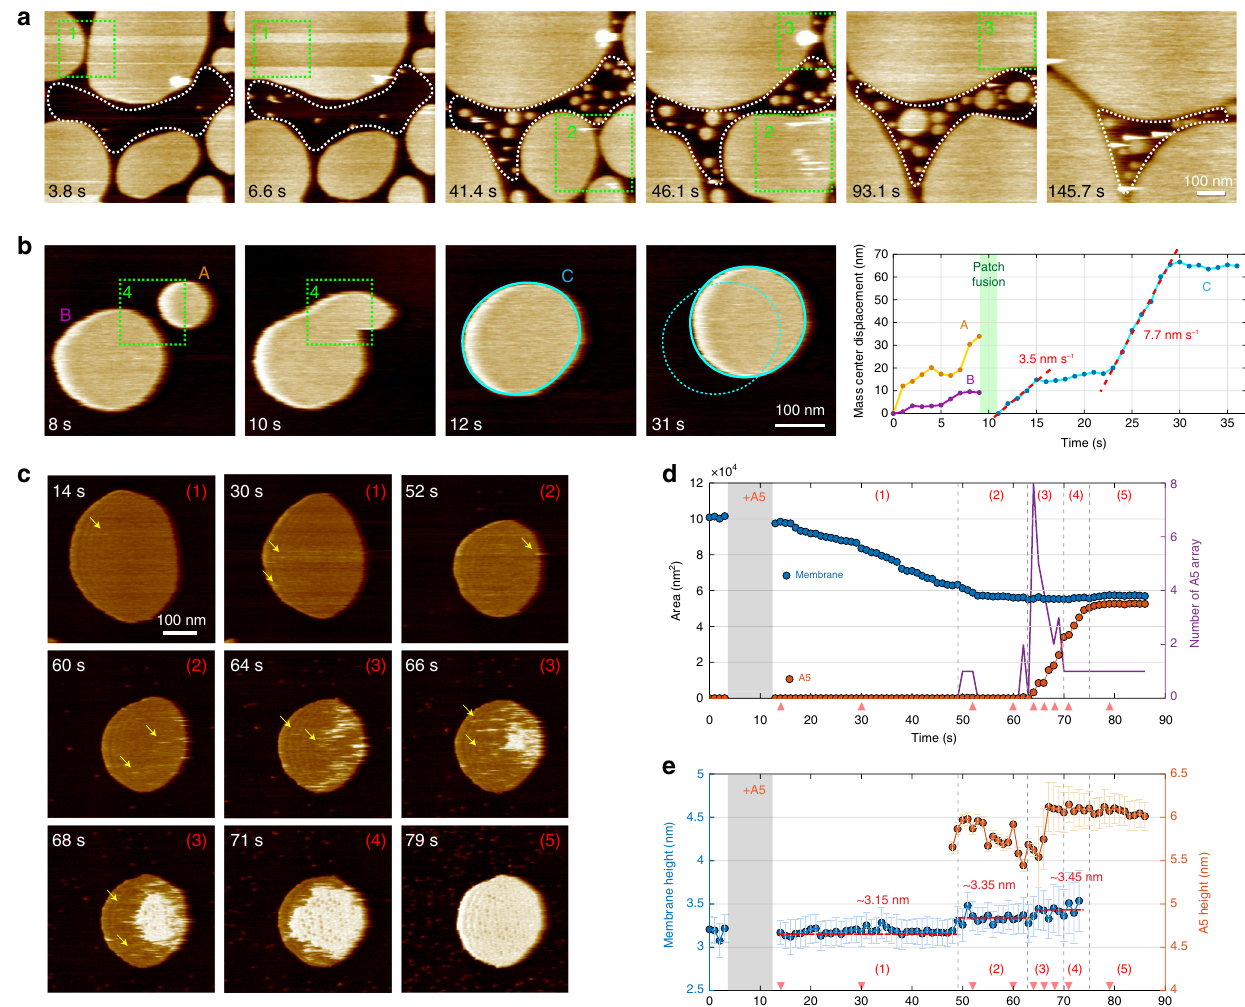
Fig. 3 A5 2D-lattice growth alters the characteristics of the underlying lipid membrane. a HS-AFM image frames (Supplementary Movie 2) showing the ef fi cient formation of a supported lipid bilayer (SLB) membrane on mica through vesicle adsorption and spreading (white dashed outlined) and patch fusion (green dashed rectangles). b In the absence of additional vesicles deposited from buffer, the fusion of two small membrane patches can produce a new larger membrane patch that has freedom in surface diffusivity (Supplementary Movie 3). Right graph panel: movement estimated by mass center displacement through fusion process and surface diffusion. c HS-AFM image sequence from a longer HS-AFM movie (acquisition speed: 1 s per frame, Supplementary Movie 4) showing membrane-patch size decrease during A5 adsorption, self-assembly, and 2D-lattice growth. Yellow arrows indicate fast- diffusive, small A5 aggregates. d Time-lapse analysis of area and the number of A5 arrays (minimum size ≥ 200 nm 2 ). Red arrows indicate the time of representative HS-AFM frames shown in c . Based on the changes in membrane area, A5 coverage, and A5-aggregate number, fi ve distinct periods during the A5 self-assembly process are identi fi ed as following: (1) membrane shrinkage upon A5 addition, (2) A5 self-assembly into small A5 aggregates, (3) abundant A5 adsorption and coalescence of A5 aggregates in a large-scale 2D-lattice, (4) growth of a 2D-lattice until the membrane was fully covered, and (5) a solid A5-protective membrane. The assigned periods in d are labeled in the top-right corner of corresponding images in c . e Time-lapse analysis of mean height above the mica plane of the membrane patch and A5 aggregates. Each data point is the difference between centers Gaussian fi ts of the height distributions of the mica, the membrane, and the A5 with the error bar determined by the peak width of the Gaussian fi t of the membrane/A5 height distribution (Supplementary Fig. 1). The thickness of bare membrane and A5-covered membrane are 3.15 ± 0.2 nm and 6.1 ± 0.2 nm, respectively. The A5 self-assembly process promotes an average membrane thickness increase to 3.35 ± 0.2 nm and 3.45 ± 0.3 nm during period (2) and (3), respectively. Detailed comparison among height histograms is provided in Supplementary Fig.